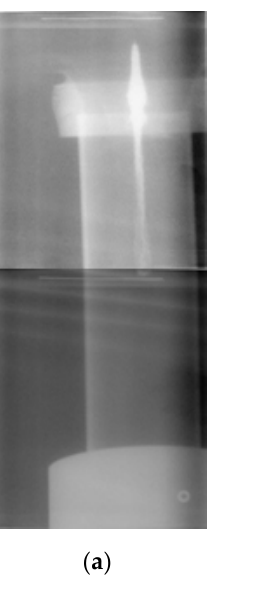
Figure 9. X-ray image of the Zr-based amorphous alloy jet (H4): ( a ) captured by light outlet A at 32.748 μs and ( b ) captured by light outlet B at 40.802 μs.